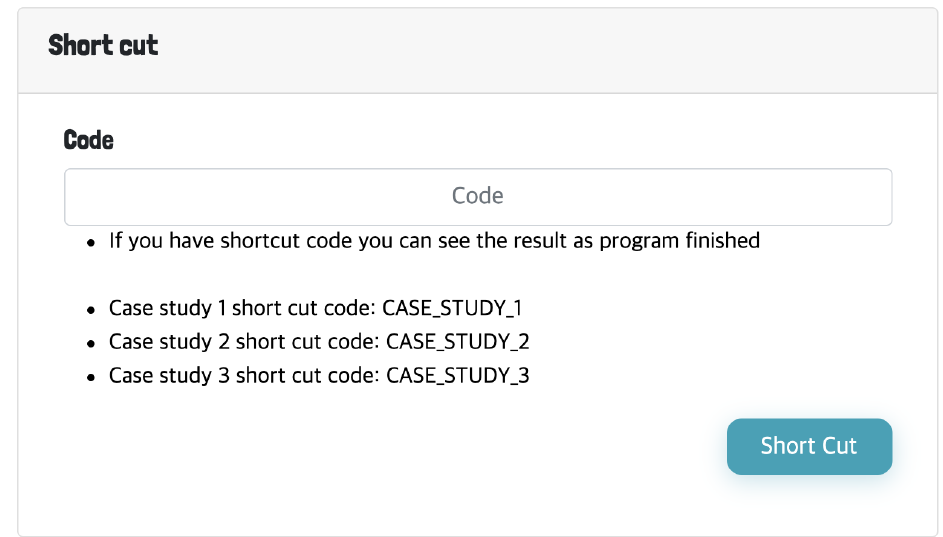
Figure 3. The shortcut panel for searching previous analysis